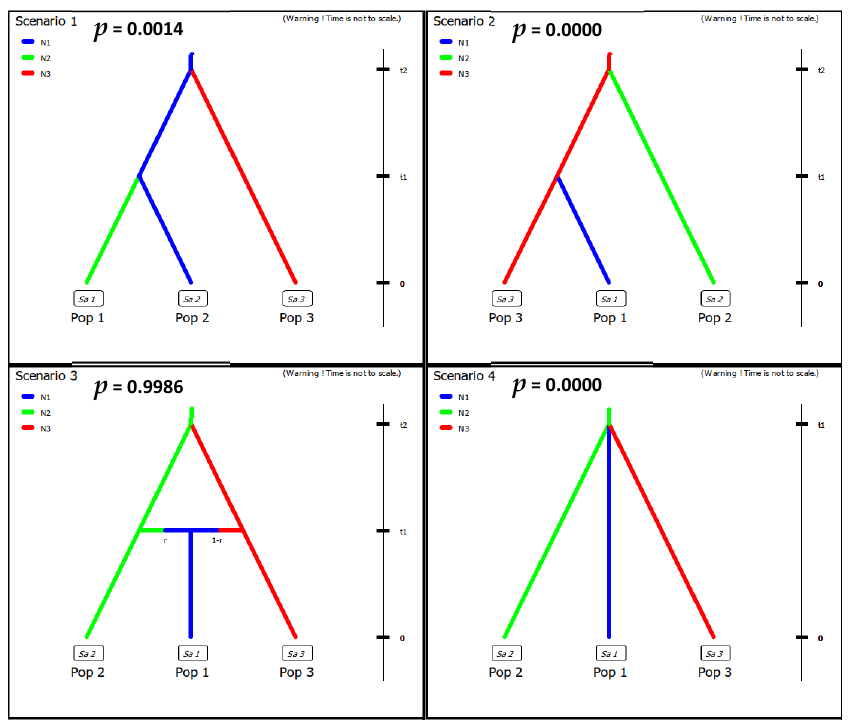
Figure 4. Demographic scenarios designed for DIYABC analysis. Pop 1: main M. athalia , Pop 2: Balkan lineage, Pop 3: M. celadussa. The logistic regressions of posterior probabilities are given for each scenario suggesting the third scenario as the fittest